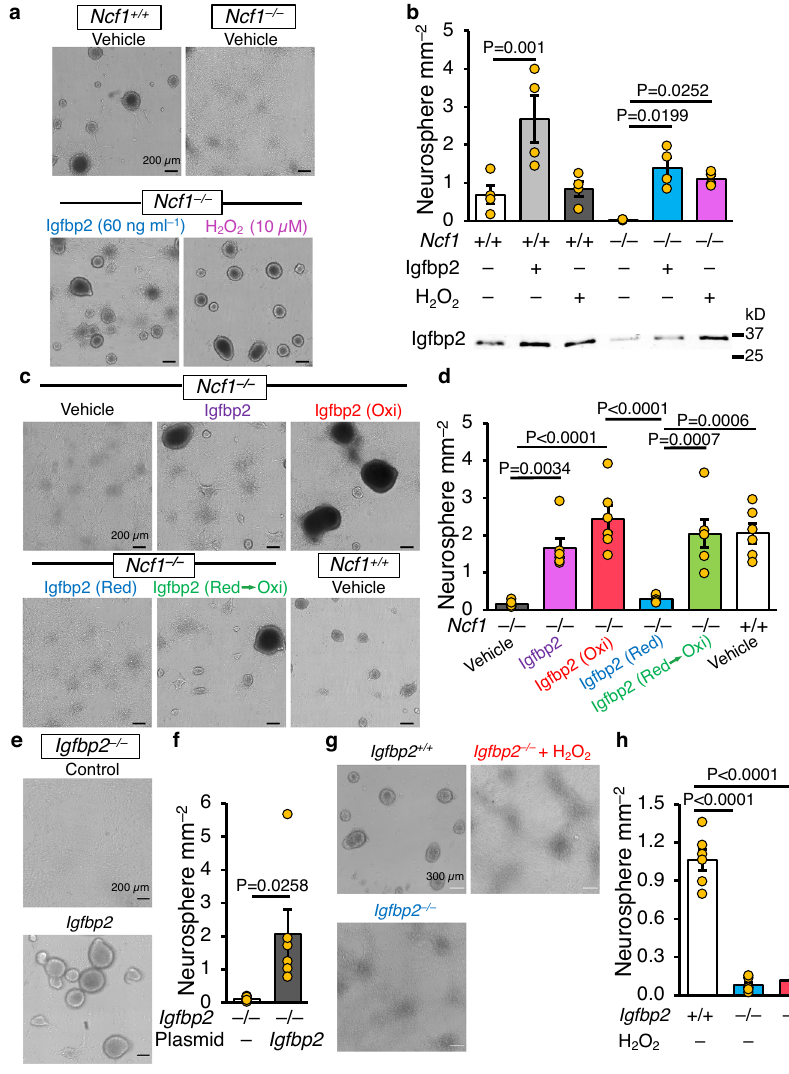
Fig. 2 | Non-reduced Igfbp2 is necessary for NSC lineage commitment. a , b Second-passage WT and Ncf1 – / – NSCs were treated with mouse recombinant insulin-like growth factor-binding protein 2 (Igfbp2) or H 2 O 2 24 – 28h after plating. a Photomicrographs of NSCs 5 days after treatment with Igfbp2 (60ngml – 1 ) or H 2 O 2 (10 µ M). b Quanti fi cationof neurospheres ≥ 60 µ m indiameter( n =4 donors). Western blot below the bar graph shows Igfbp2 levels in the medium 5 days post- treatment. c Photomicrographs of NSCs 8 days after treatment with 100ngml – 1 native Igfbp2, H 2 O 2 -treated (Oxi), DTT-treated (Red), or DTT then H 2 O 2 sequen- tially treated (Red → Oxi) Igfbp2. d Quanti fi cation of neurospheres ≥ 60 µ m